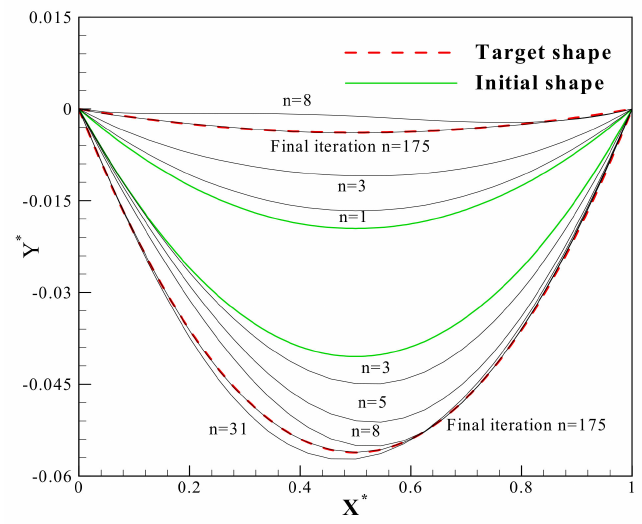
Figure 9. Procedure of geometry correction of a sharp-edged blade cascade (shown in the non- dimensionalized coordinates of X* and Y*), in the validation of UESA in transonic flow regime.